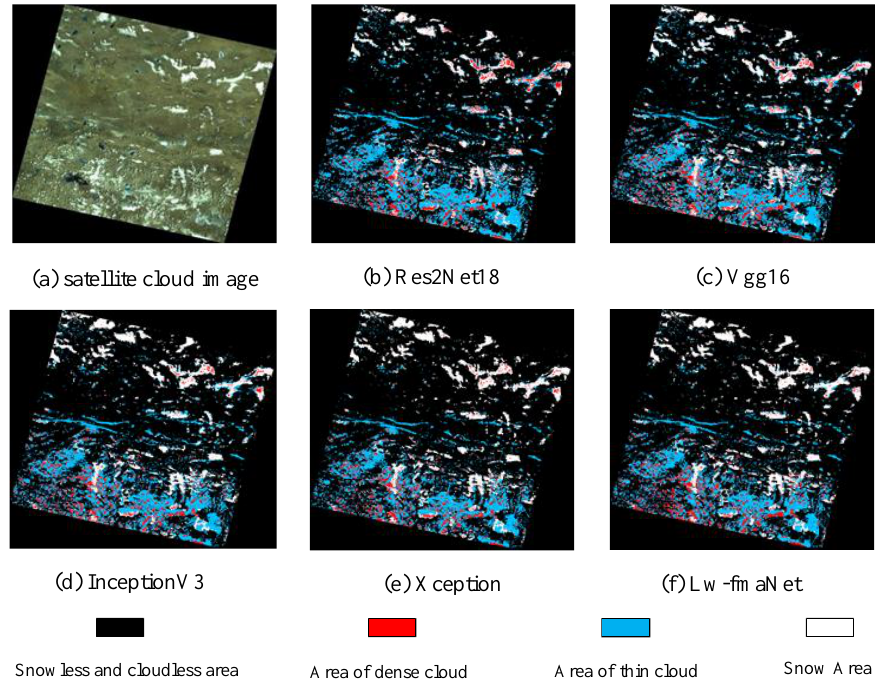
Figure 10. Cloud and snow recognition effect map of different Models in plateau